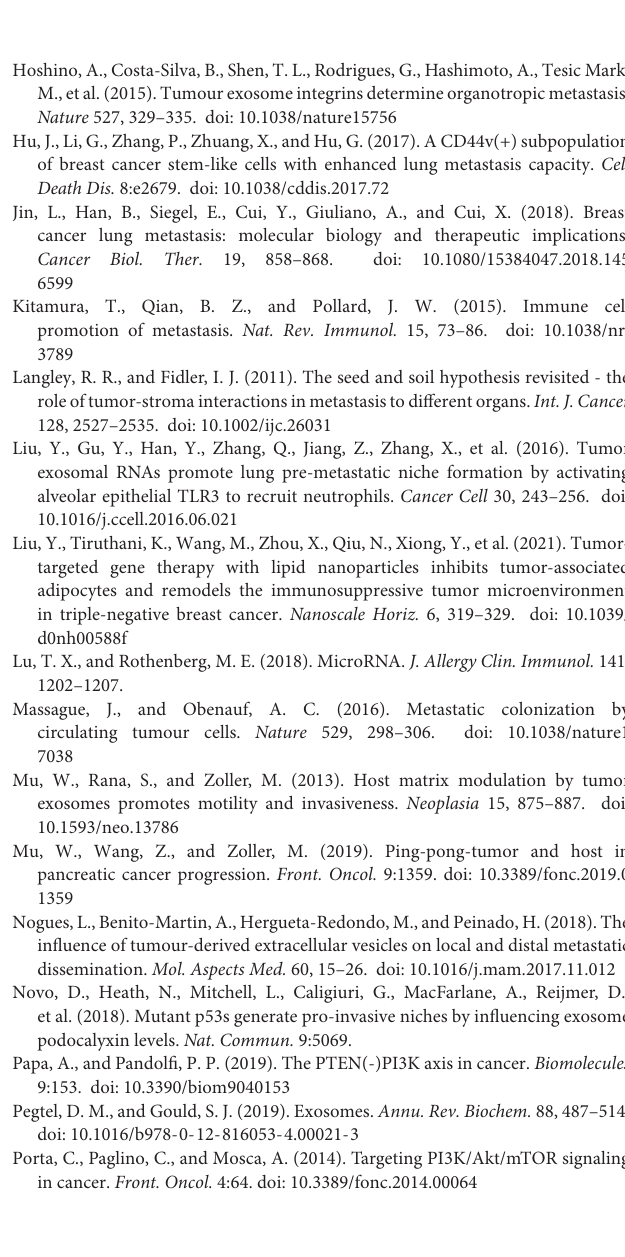
Supplementary Figure 1 | Gating strategies for the identification of MDSCs subsets. Gating strategy used to define MDSC subpopulations in orthotopic breast tumor (above) and lung metastasis tumor (below). Supplementary Figure 2 | Immunofluorescence analysis for primary lung cells. Immunofluorescence analysis for pulmonary endothelial cells, lung fibroblasts and alveolar epithelial type II cells. Supplementary Figure 3 | Quantification of the protein expression. (A) Quantification of the relative expression of the proteins in AEC II co-transfected with 4T1-Exo or miR-200b-3p mimics. (B) Quantification of the relative expression of the proteins in exosome-trained AEC II co-transfected with miR-200b-3p inhibitors. Supplementary Figure 4 | Relative expression of the proteins. mRNA expression of CCL2 in lung fibroblasts, AEC II, and pulmonary endothelial cells treated with 4TO7 or 4T1 derived